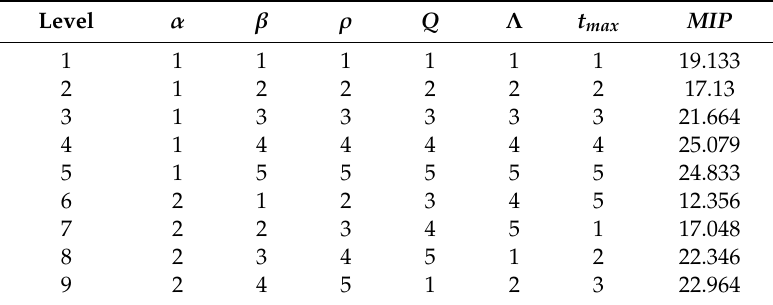
Table A4. ACO algorithm parameters orthogonal experiment